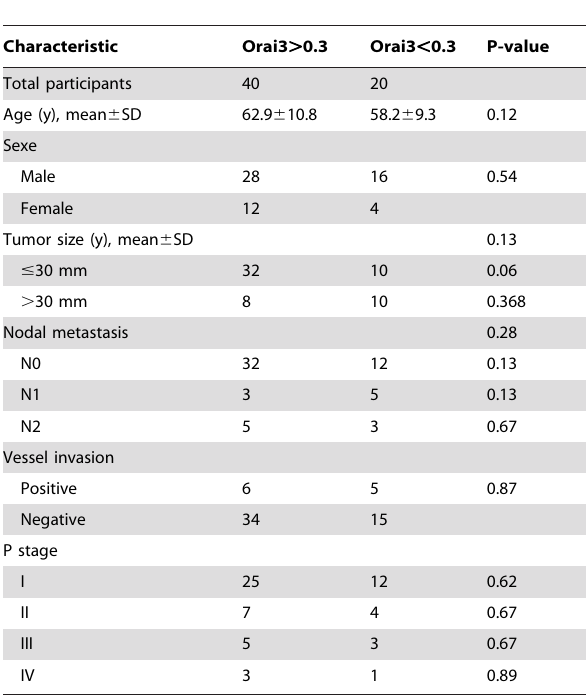
Table 1. Clinical characteristics of patients who underwent pulmonary resection for adenocarcinoma.